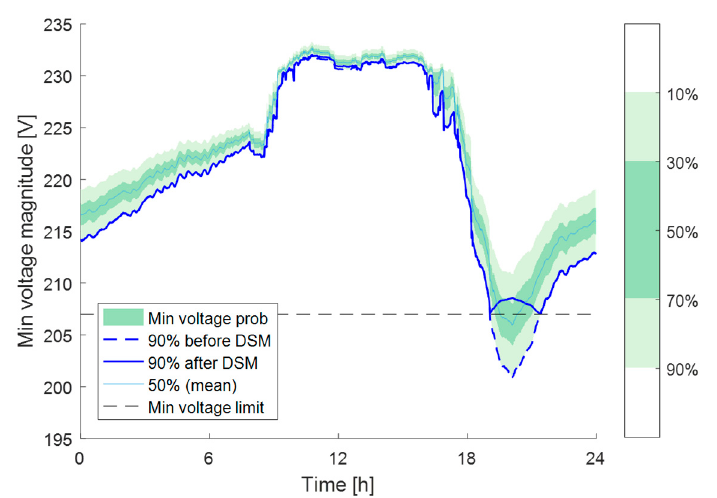
Figure 5. 90% probability minimum voltage magnitudes over time.